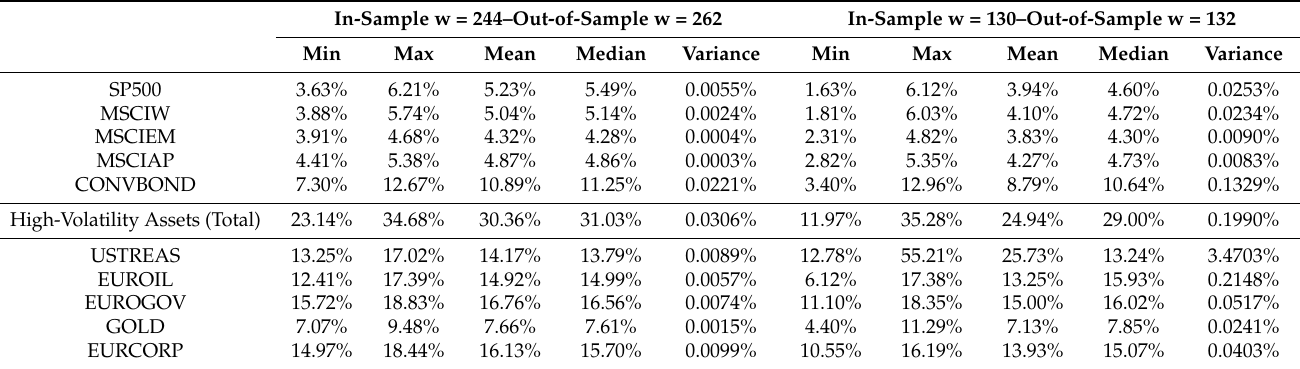
Table 6. Asset marginal weight contribution to the Conventional Portfolios.